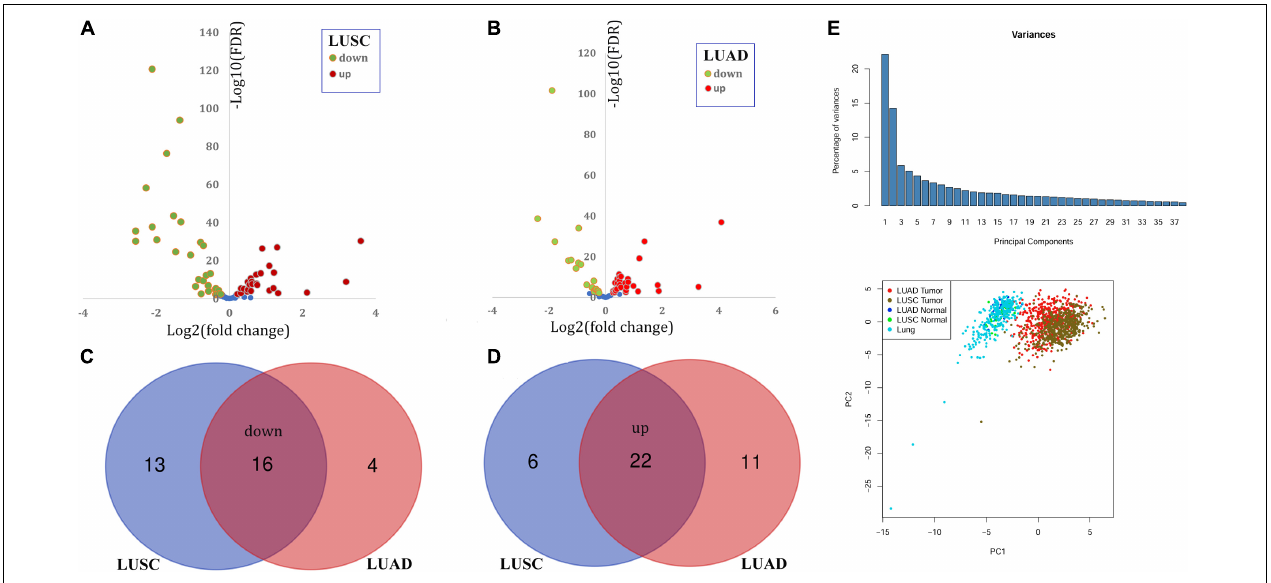
FIGURE 1 | Identification and expression profiles of common differentially expressed peroxisome pathway genes (C-DEPGs) in NSCLC. (A) 57 DEPGs including 29 down-regulated and 28 up-regulated genes in LUSC. (B) 53 DEPGs including 20 down-regulated and 33 up-regulated genes in LUAD. (C) Venn diagram of the overlapping down-regulated DEPGs in LUSC and LUAD (down-regulated C-DEPGs in NSCLC). (D) Venn diagram of the overlapping up-regulated DEPGs in LUSC and LUAD (up-regulated C-DEPGs in NSCLC). (E) Two-dimensional principal component analysis (PCA) of gene expression profiles of the C-DEPGs. Each sample is represented with a single point, with different color for each of the groups. NSCLC, non-small cell lung cancer; LUSC, lung squamous carcinoma; LUAD, lung adenocarcinoma. LUAD tumor and LUSC tumor represented tumor samples in TCGA-LUAD dataset and TCGA-LUSC dataset, respectively. LUAD normal and LUSC Normal represented normal lung samples in TCGA-LUAD dataset and TCGA-LUSC dataset, respectively. Lung represented normal lung samples from The Genotype-Tissue Expression (GTEx) project.